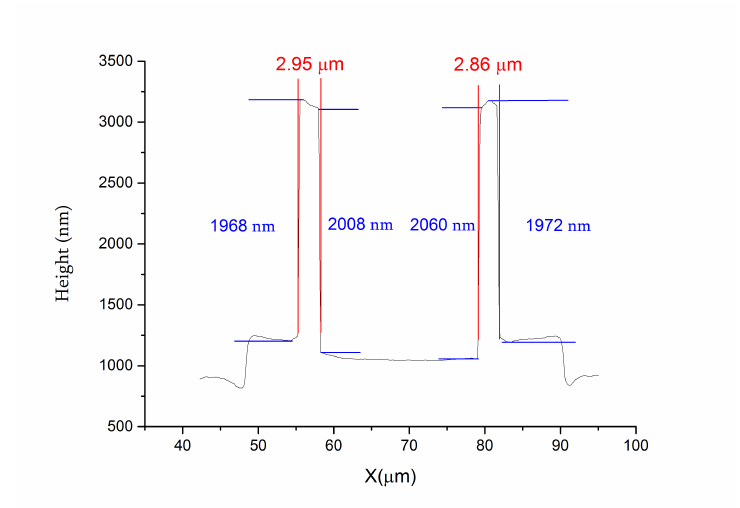
Figure 6. Measured profile of an embossed